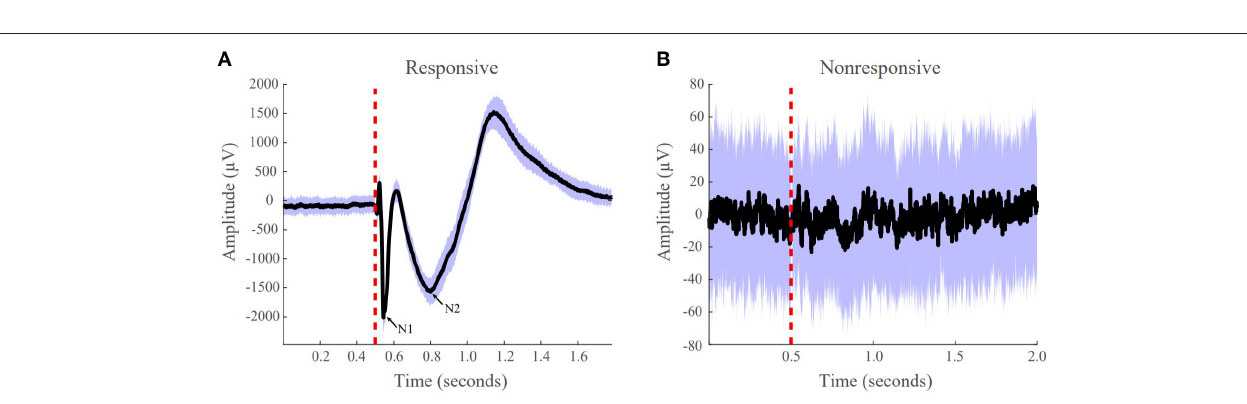
FIGURE 2 | Examples of responsive and non-responsive waveforms from patient iEEG data. (A) Responsive CCEPs were defined as an absolute value of the post-stimulus amplitude > 100 uV from the baseline. The N1 and N2 peak are labeled. (B) Non-responsive CCEP that does not meet the 100 uV post-stimulus amplitude threshold. The black line indicates the average evoked response, the purple boundaries denote one standard deviation, and the red vertical dotted line indicates the stimulation